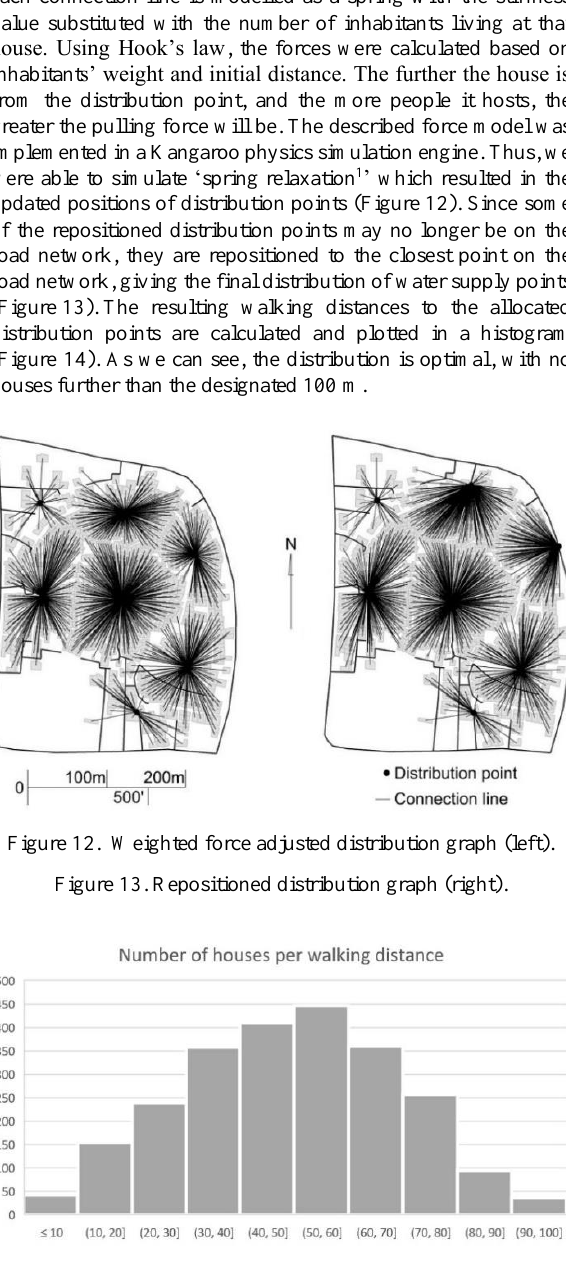
Figure 14. Houses per walking distance